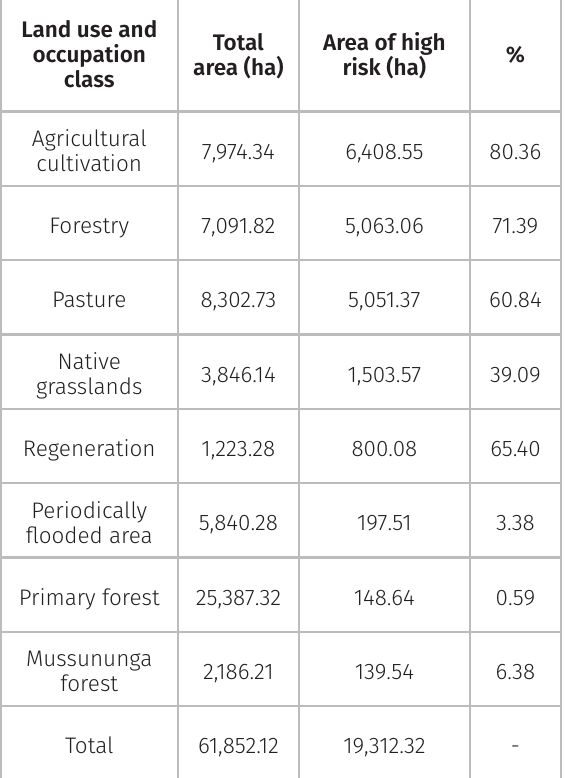
Table III. Spatial autocorrelation of the high fire risk in the study area and class corresponding of land use and